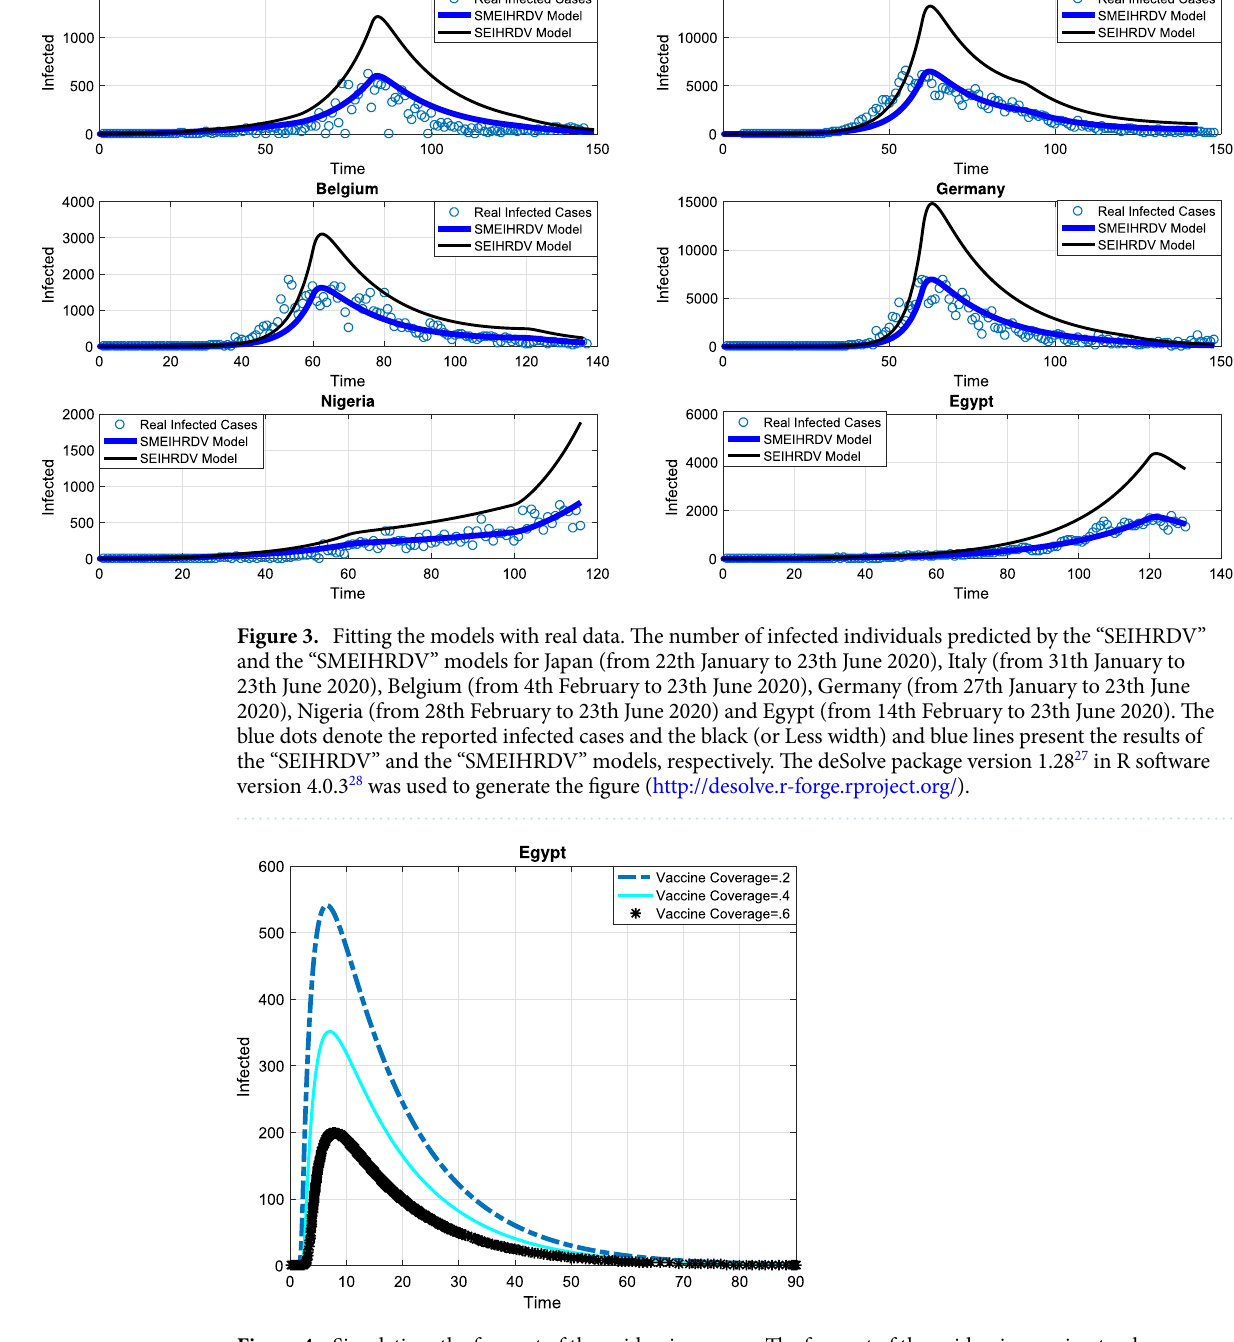
Figure 4. Simulation, the forecast of the epidemic process. The forecast of the epidemic growing tendency for infected cases through the SMEIHRDV model in Egypt. The results show that by increasing the vaccine coverage, the epidemic peak for infected cases decreases. The number of infected cases at the epidemic peak is approximately 540 in Egypt and it has reduced to 200 by the increasing vaccine coverage from 0.2 to 0.6. N = 102, 000,